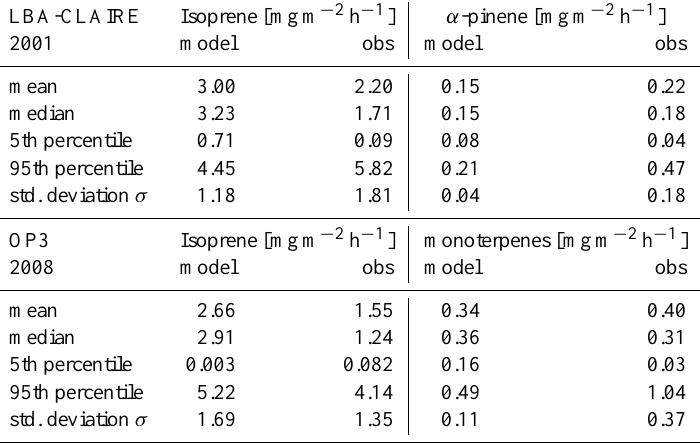
Table 6. Statistical comparison of model results with emission fluxes observed during the LBA-CLAIRE campaign in July 2001 in the central Amazon and during OP3 study in June–July 2008 in